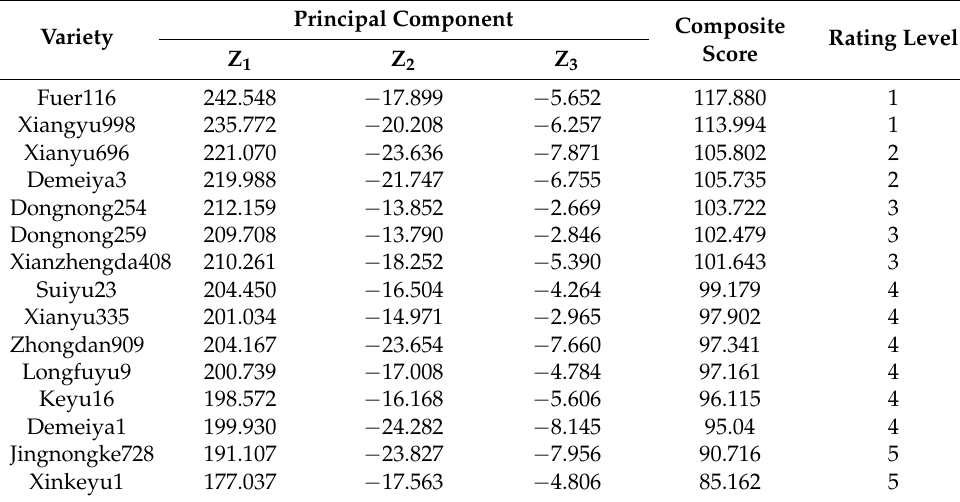
Table 7. Principal component scores and composite